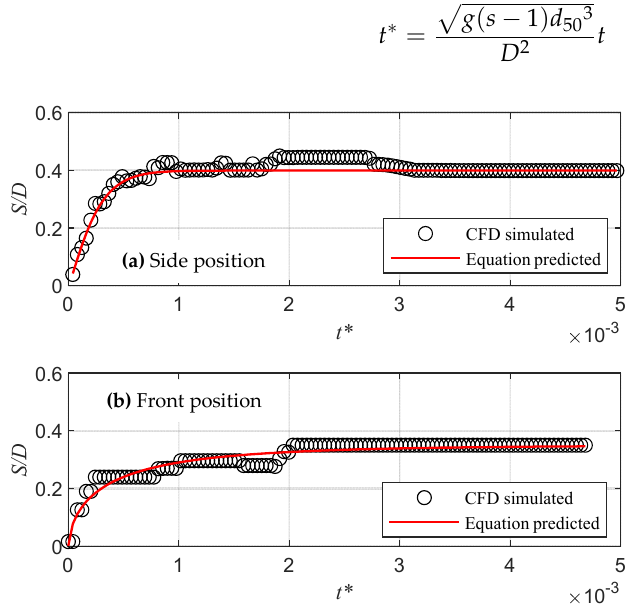
Figure 14. Comparison of scour depth development between the equation predicted and CFD simulated results at the ( a ) side and ( b ) front positions of the structure.